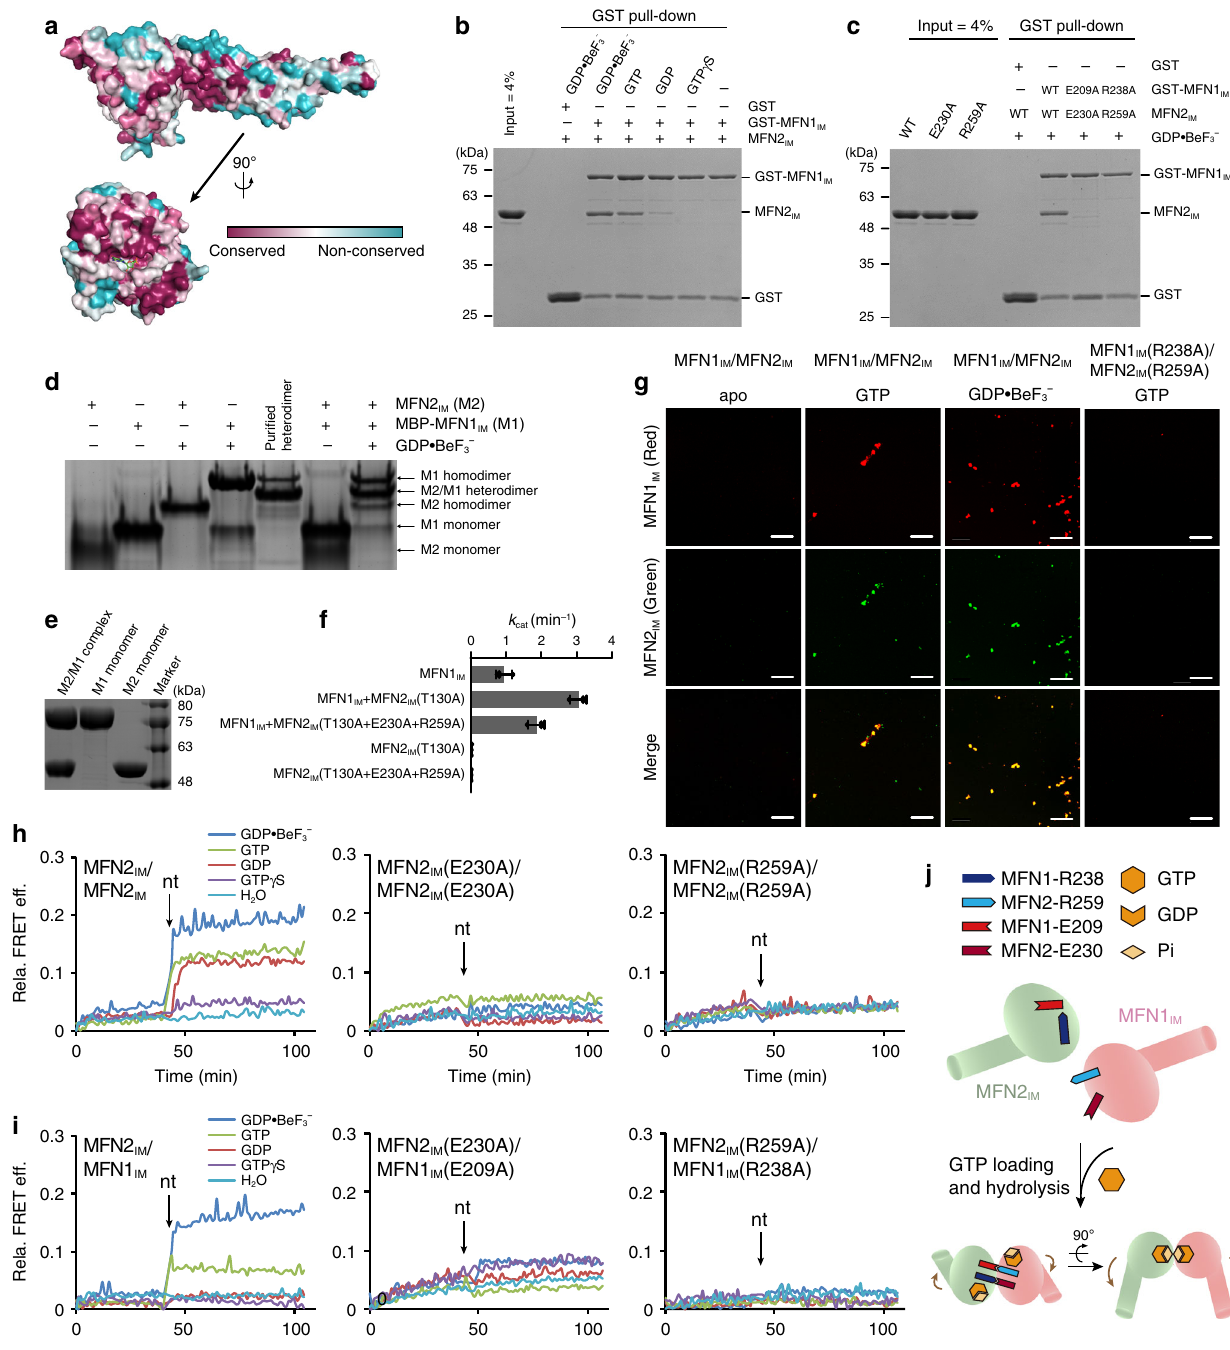
Fig. 5 MFN2 interacts with MFN1 via G domain. a Surface conservation analysis reveals that the G interface is a highly conserved area in mitofusins. b Pull- down assays showing the interaction between MFN2 IM and GST-tagged MFN1 IM in different nucleotide-loading conditions. c Pull-down assays showing that the interaction between MFN2 IM and MFN1 IM is dependent on the G interface. d Native PAGE result showing the association between MFN2 IM and MBP-fused MFN1 IM . e SDS-PAGE showing the puri fi ed MFN2 IM /MBP-MFN1 IM hetero-complex. f MFN2 IM stimulates GTP turnover of MFN1 IM . Overall, Representative images from fi ve independent experiments are shown. Scale bar, 50 μ m. h FRET experiment showing the G domain dimerization-dependent conformational change of MFN2 IM in different nucleotide-loading conditions. The time point for the addition of corresponding nucleotides is indicated by an arrow for each panel. nt denotes nucleotide. i FRET experiment showing the conformational change of MFN2 IM and MFN1 IM upon association via the G domains in GTP- and GDP (cid:1) BeF (cid:3) loading conditions. j A model for the trans association between MFN2 IM and MFN1 IM . Source data are provided as 3